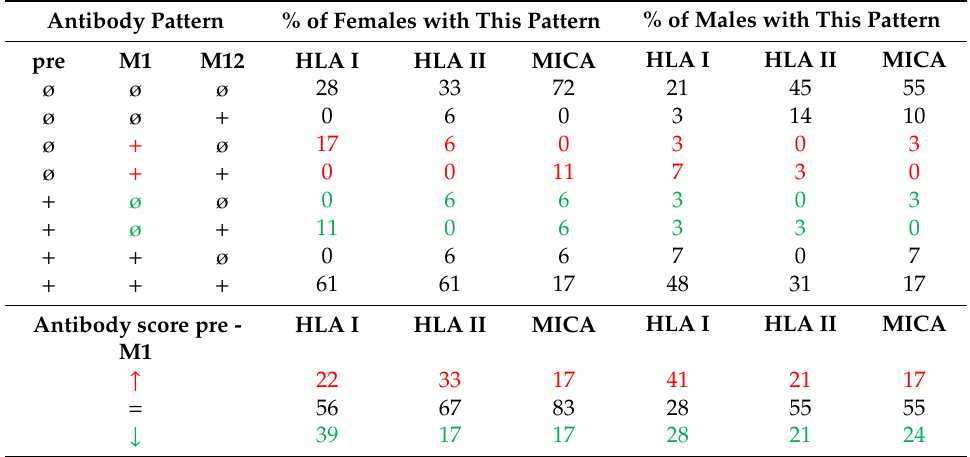
Table 5. Individual courses of HLA / MICA antibodies in 21 female and 28 male kidney transplant recipients pre and at month 1 (M1) and month 15 (M15) after vaccination with Pneumovax. Antibody Pattern % of Females with This Pattern % of Males with This Pattern pre M1 M12 HLA I HLA II MICA